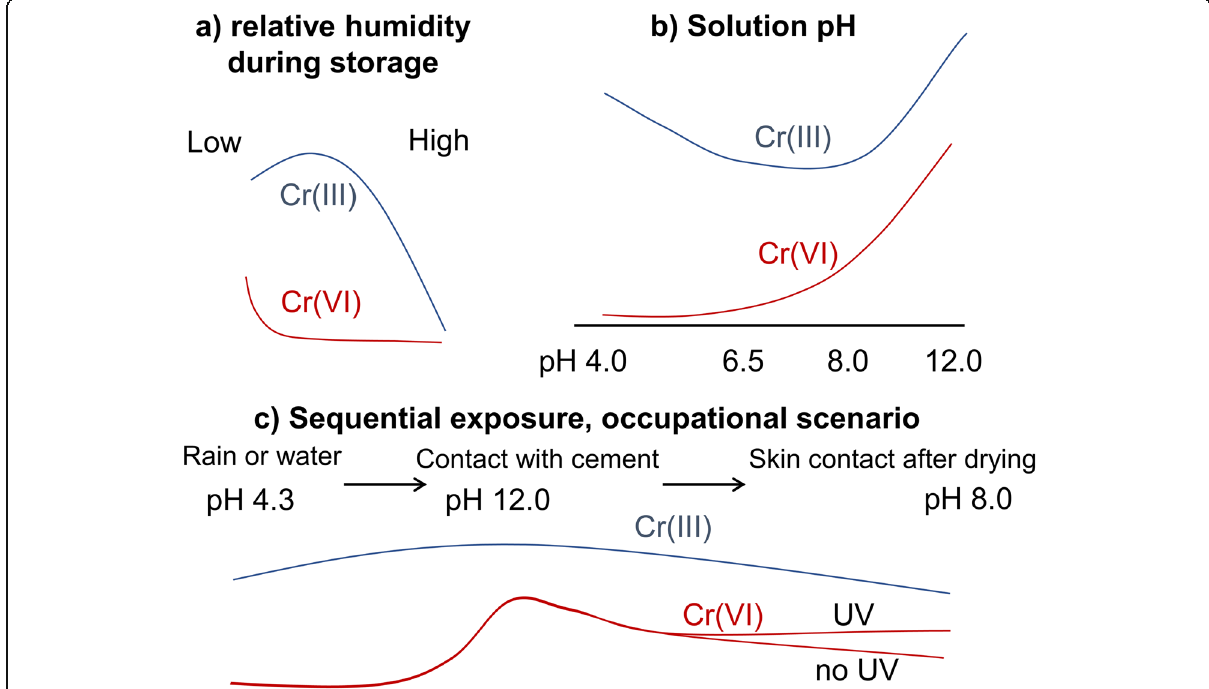
Fig. 4 Different pre-exposure (storage) and exposure scenarios for a chromium-tanned leather without antioxidants, such as common purely chromium-tanned work gloves: The influence of relative humidity prior to exposure / skin contact ( a ), the influence of solution pH during exposure / skin contact ( b ), and an occupational exposure scenario involving exposure to rain, cement or alkaline solutions, and UV irradiation during drying / storage. Schematically redrawn from the results shown in [41]. Cr(VI) – hexavalent chromium; Cr(III) – trivalent chromium; UV – ultraviolet